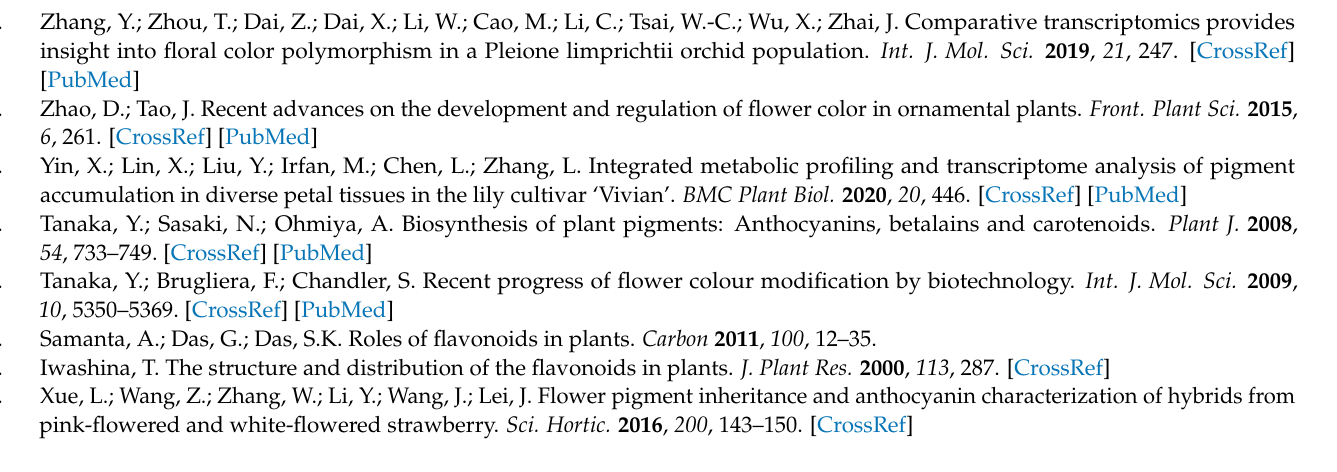
pigment of ‘QN’. (a) Color reaction in petroleum ether. (b) Color reaction in the hydrochloric acid. (c) Color reaction in the ammonia. Figure S2: UPLC separation diagram at 520 nm of ‘QN’ at different stages of development. (A) Anthocyanin stand compounds. (B) The petal exaction of ‘QN’ at S1. (C) The petal exaction of ‘QN’ at S2. (D) The petal exaction of ‘QN’ at S3. (E) The petal exaction of ‘QN’ at S4. (F) The petal exaction of ‘QN’ at S5. The same for below. Figure S3: UPLC separation diagram at 350 nm of ‘QN’ at different stages of